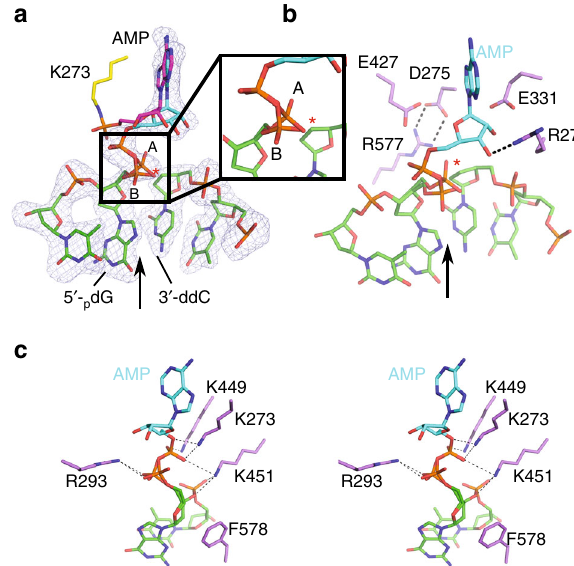
Fig. 5 Analysis of interactions involving the DNA – adenylate prior to nick sealing. a The lysyl-adenylate from the open complex (K273 in yellow, AMP in magenta) was superimposed with the DNA – adenylate (AMP in cyan, DNA in green). Alternate conformations of the primer terminal 5 ′ - phosphate are shown and indicated as “ A ” or “ B ” (magni fi ed view in inset), and the putative position of the 3 ′ -OH is marked with a red asterisk. A simulated annealing omit F o − F c difference electron density map (gray) is shown for residues in the closed DNA – adenylate complex, contoured at 2.5 σ . b Candidates for divalent metal binding within the LigIV active site. The nick junction is indicated by a black arrow. c Stereo diagram of potential interactions involved in charge neutralization and/or substrate stabilization. A detailed list of the hydrogen-bonding interactions is given